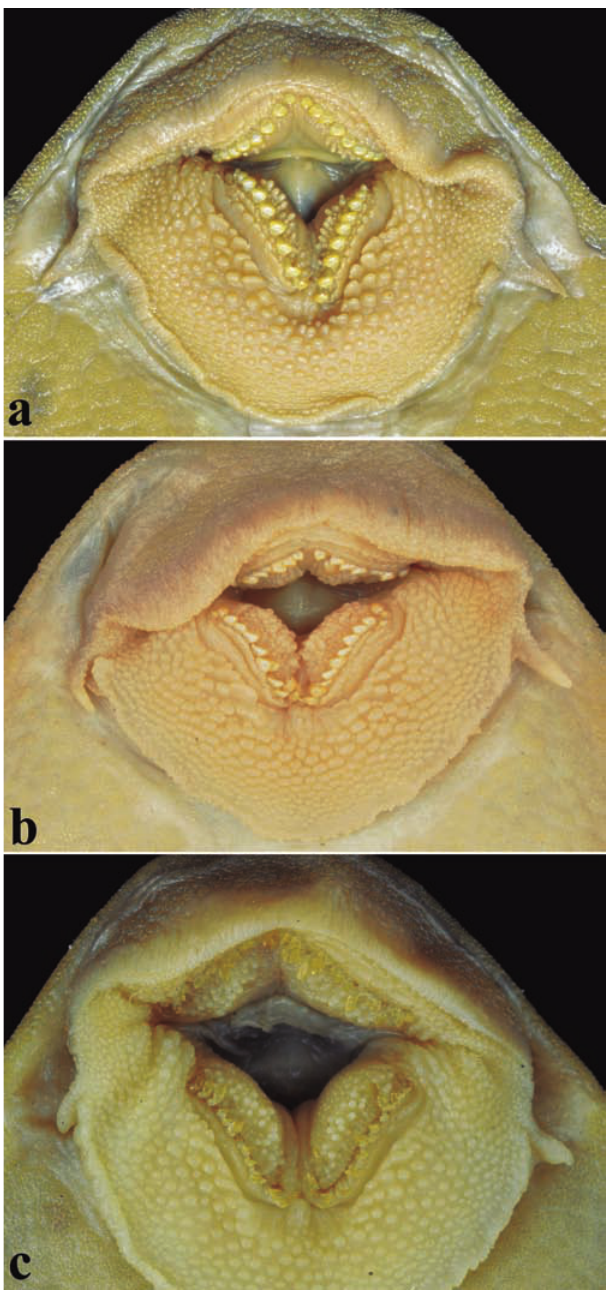
face of upper and lower jaws; (b) Hypostomus basilisko , ho- lotype, MZUSP 111110, 182.5 mm SL, showing the agglomer- ated papillae on inner face of upper and lower jaws; and (c) Hypostomus khimaera , MZUSP 111129, holotype, 139.1 mm SL, showing weakly developed papillae not forming series.